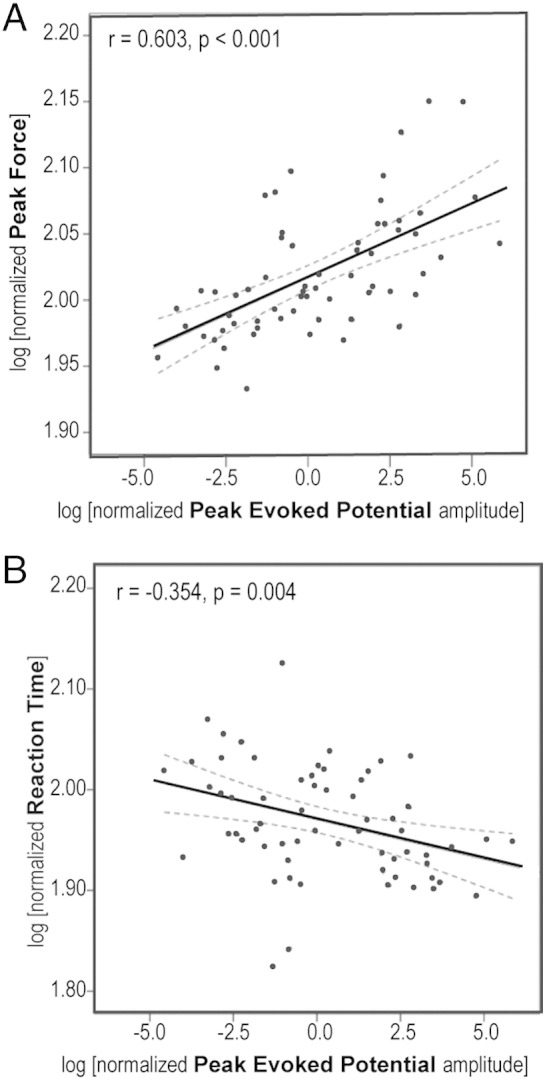
Scatter-plots relating increases in average absolute peak evoked potential amplitude to enhancements in (A) peak force and (B) reaction time, relative to the average of peak responses to the lowest intensity imperative cues. Data are derived from the remaining four sound intensities in the eight subjects. Solid lines represent best-fit lines fitted by simple linear regression. Dashed lines represent 95% CI of the regression line.